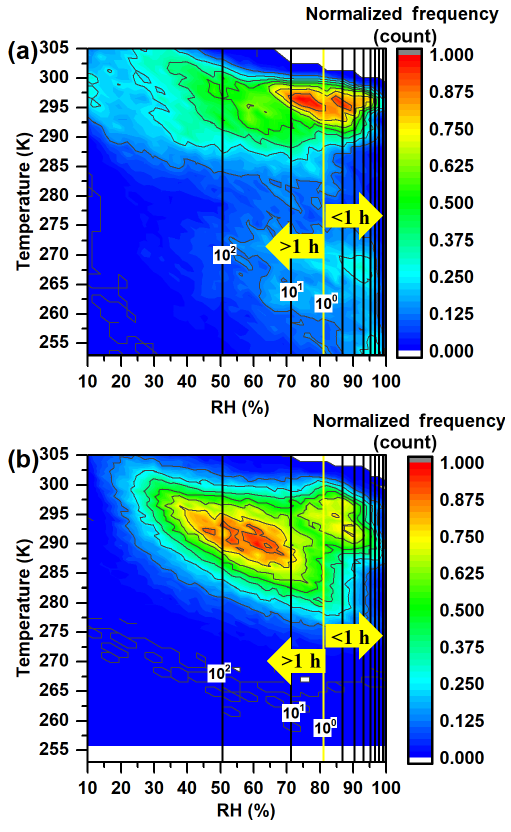
Figure 8. Six-hour normalized frequency counts of temperature and RH in the planetary boundary layer (PBL) (colour scale) to- gether with the mixing times for organic molecules within 200nm α -pinene SOA particles (contours) calculated based on the parame- terization generated using the viscosities from Zhang et al. (2015). Panel (a) shows the conditions for January and panel (b) shows the conditions for July. Mixing times (contours) are reported in hours. Frequency counts in the PBL were only included for the condi- tions where the mass concentration of total organic aerosol was > 0 . 5µgm − 3 at the surface. The viscosity parameterization used to calculate mixing times was based on α -pinene SOA generated using mass concentrations of ∼ 70µgm − 3 .